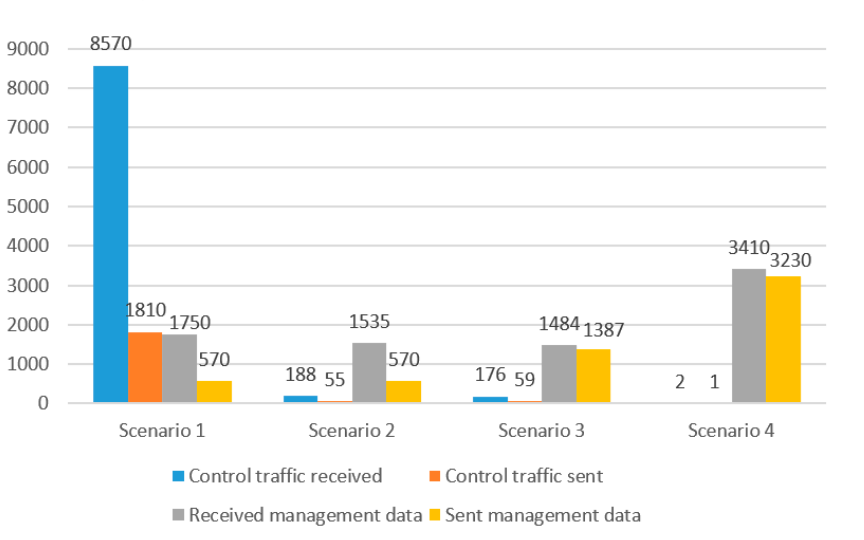
Figure 13. Correlation of management and control traffic.